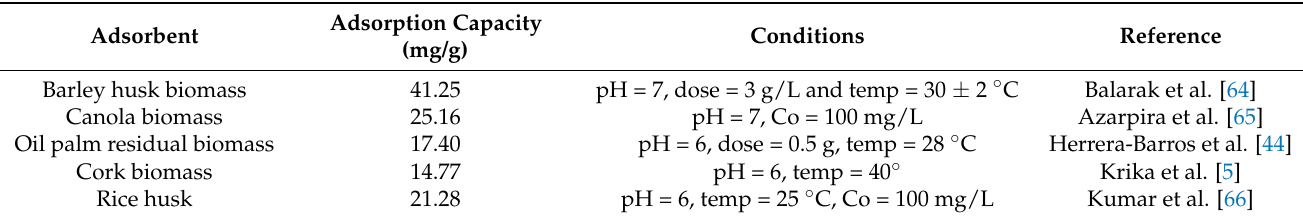
Table 3. Comparative adsorption capacities reported in previous works for different